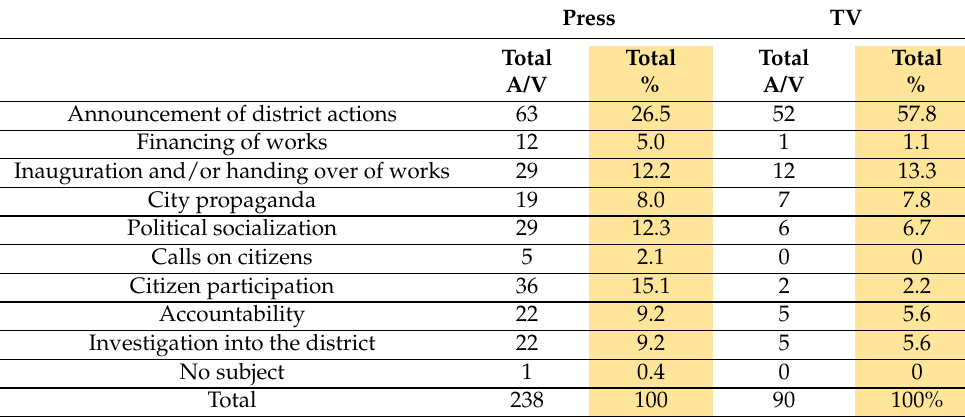
Table 5. Headline subject (Source: Authors).